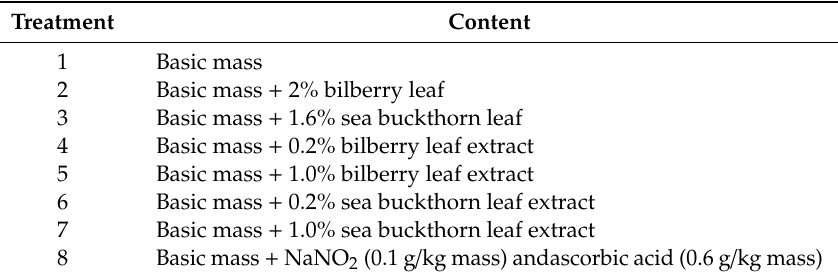
Table 1. Pork sausage